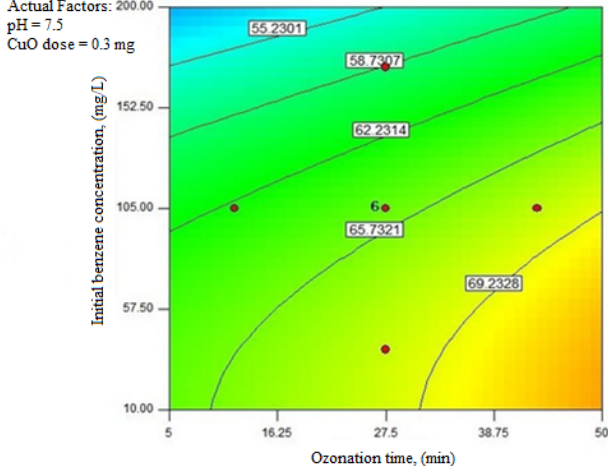
Fig. 8: The effect of initial benzene concentration on the removal efficiency